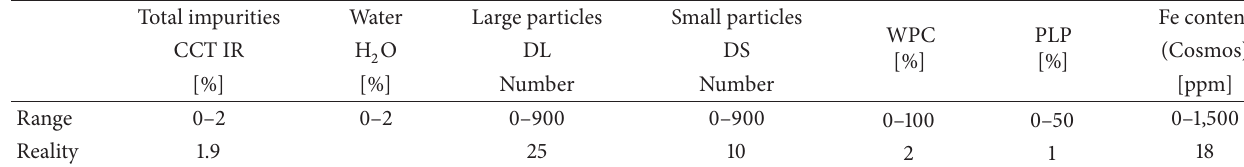
Table 5: The measurement results for sample B.